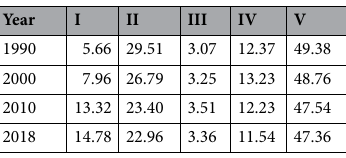
Table 3. Quantitative description of changes in habitat quality levels (%).